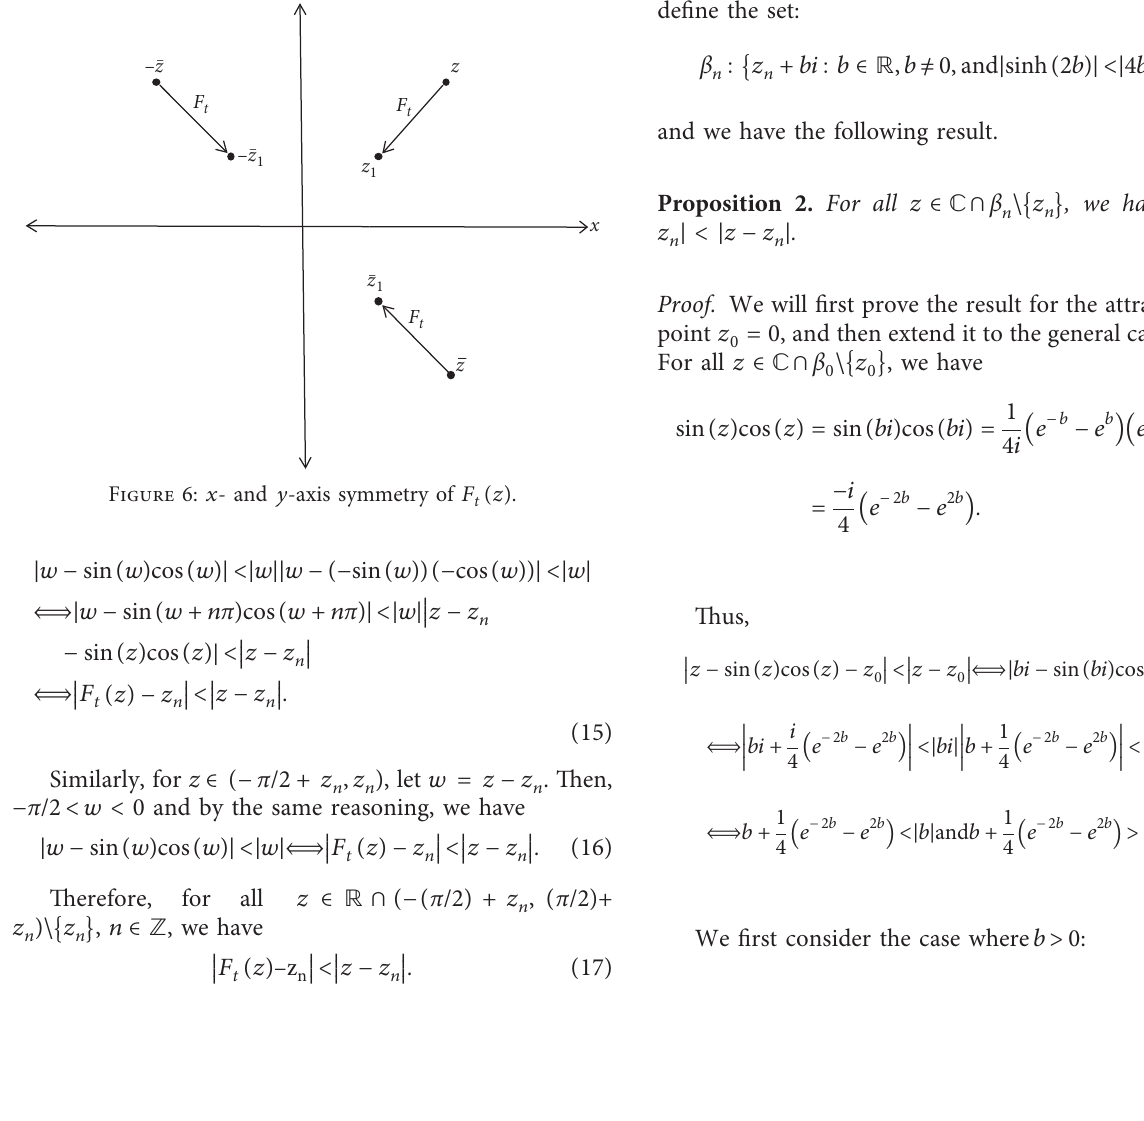
z � 0. (b) The largest bulb attached to A ∗ t about 0